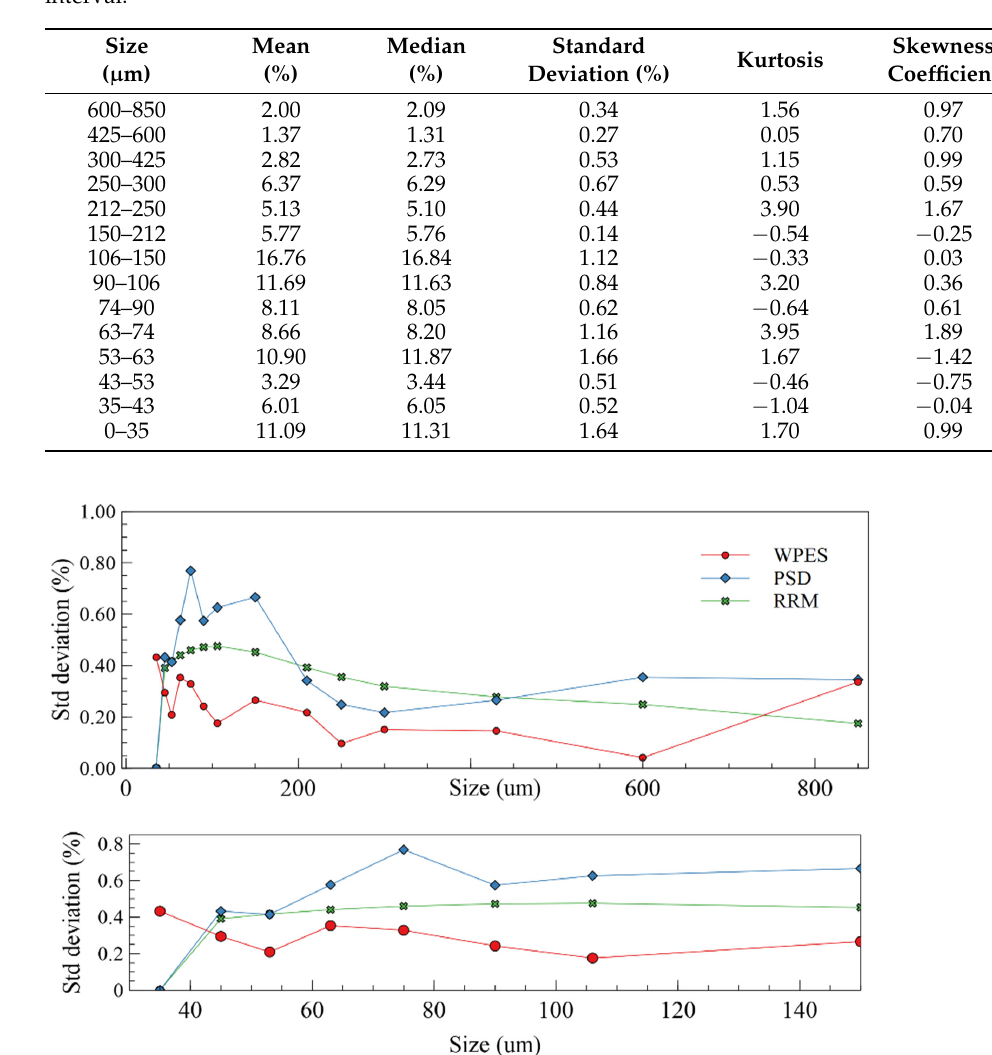
Figure A1. Standard deviation for grinding time of 8 min with 95% confidence. Top , WPES, PSD and RRM for all range sizes; Bottom , those for mainly fine sizes.